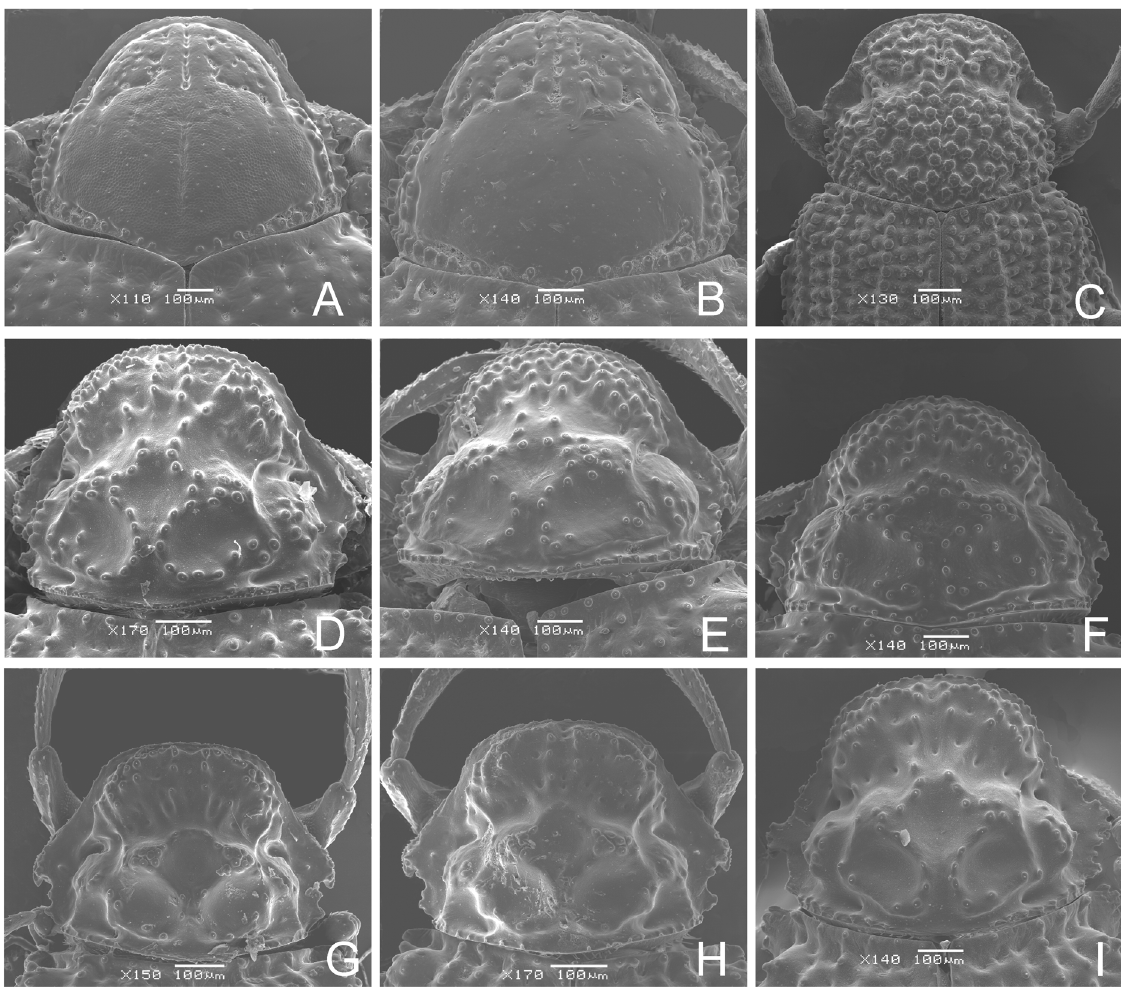
Fig. 7. Pronotum of Georissus spp. A . G . ( G .) canalifer Sharp, 1888. B . G . ( G .) babai Satô, 1970. C . G . ( Ni .) granulosus Satô, 1972. D . G . ( Ne .) japonicus Satô, 1972. E–F . G . ( Ne .) kurosawai Nakane, 1963 from Hokkaido (E) and Nagano (F). G–H . G . ( Ne .) takahashii sp. nov. from Kochi (G) and Okinawa (H). I . G . ( Ne .) satoi sp.